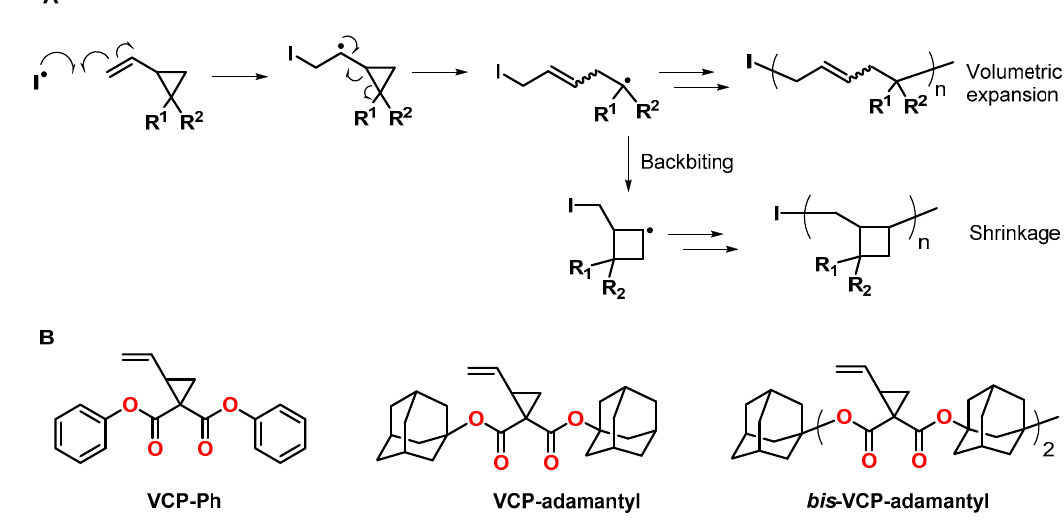
Figure 7. A : Schematic representation of the RROP of vinylcyclopropanes. B : Structures of vinylcyclopropanes that show Figure 7. (A ): Schematic representation of the RROP of vinylcyclopropanes. ( B ): Structures of vinylcyclopropanes that show volumetric expansion during RROPs. volumetric expansion during